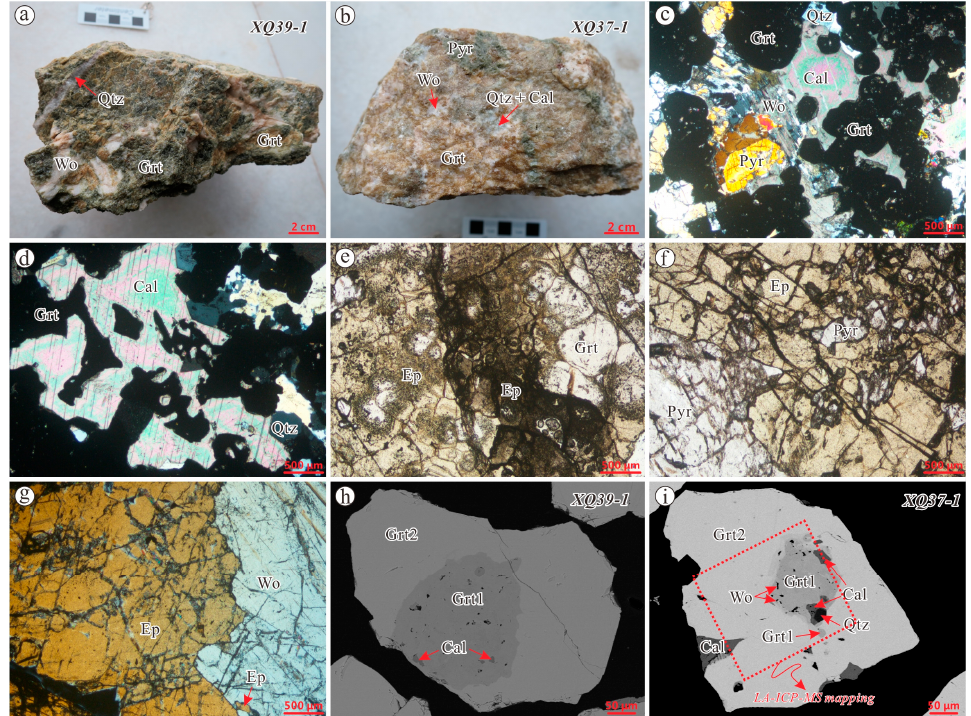
Figure 4. Photographs showing representative mineral assemblages and textural features of the garnet skarns. ( a ) Hand specimen for Sample XQ39-1, showing the skarn mineral assemblage of garnet–wollastonite, crosscut by late quartz vein. Garnet in sample XQ39-1 is from beige to dark green in color; ( b ) Hand specimen for Sample XQ37-1, showing the skarn mineral assemblage of garnet–wollastonite–pyroxene, locally replaced by late quartz and calcite; ( c ) The garnets are homogeneous and contain no distinct oscillatory zoning, coexisting with wollastonite and pyroxene and replaced by late calcite and quartz (CPL; XQ37-1); ( d ) Late quartz and calcite replace garnet (CPL; XQ37-1); ( e ) Late epidote extensively replaces garnet, and occur locally as a pseudomorph of garnet (PPL; XQ39-1); ( f ) Late epidote strongly replaces pyroxene (PPL; XQ39-1); ( g ) Late epidote strongly replaces wollastonite (PPL; XQ37-1); ( h ) Back-scattered electron (BSE) observation reveals two generations of garnet, with no obvious chemical oscillatory zoning; ( i ) BSE observation reveals that Grt1 coexists with irregular wollastonite and is locally resorbed by late irregular calcite and quartz. Abbreviations: Qtz = Quartz; Wo = Wollastonite; Grt = Garnet; Pyr = Pyroxene; Cal = Calcite; Ep = Epidote; Grt1 = The early generation of garnet; Grt2 = The late generation of